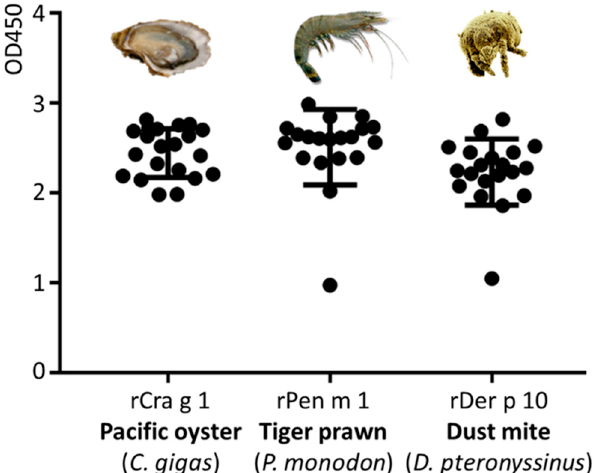
Figure 6. Patient serum IgE reactivity analysed by ELISA for three purified tropomyosins: Cra g 1 (Pacific oyster), Pen m 1 (Black tiger prawn) and Der p 10 (house dust mite) ( N = 18).